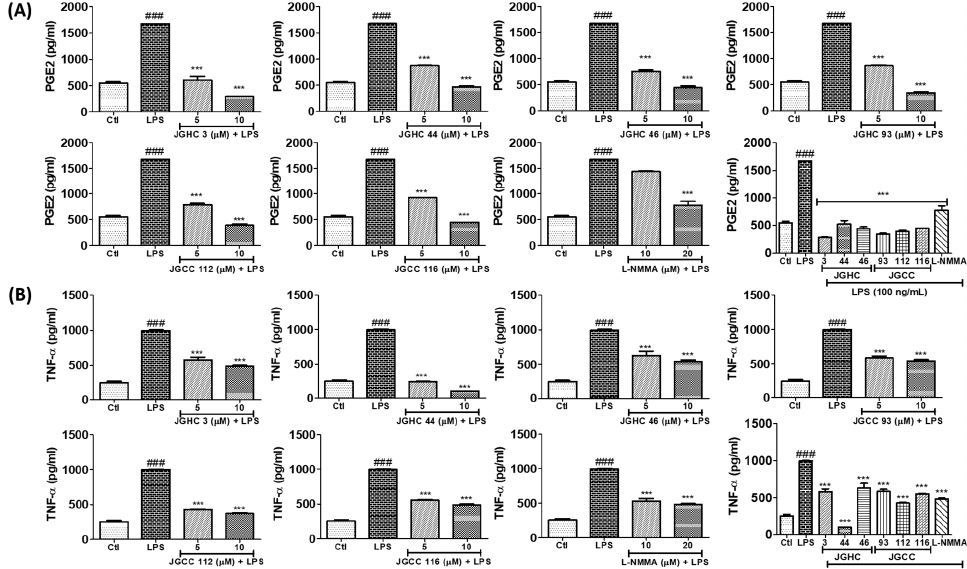
Figure 6. Active components from A. holophylla subfraction inhibited PGE2 and TNF- α -production against LPS-activated microglial cells. Measurement of pro-inflammatory mediators in BV2 cells pre-treated with the JHC 3, JGHCC 44, JGHC 46, JGCC 93, JGCC 112, and JGCC 116 subfractions and activated with LPS. In addition, the conditioned medium was used for this analysis. NG-mono-methyl- L -arginine ( L -NMMA) was the positive control. ( A ) Effect on PGE2 production and ( B ) TNF- α production. *** p < 0.001 indicates significant differences compared with treatment of LPS alone, while ### p < 0.001 indicates significant differences compared with the untreated control group. Ctl indicates untreated control cells, LPS indicates LPS-treated cells.